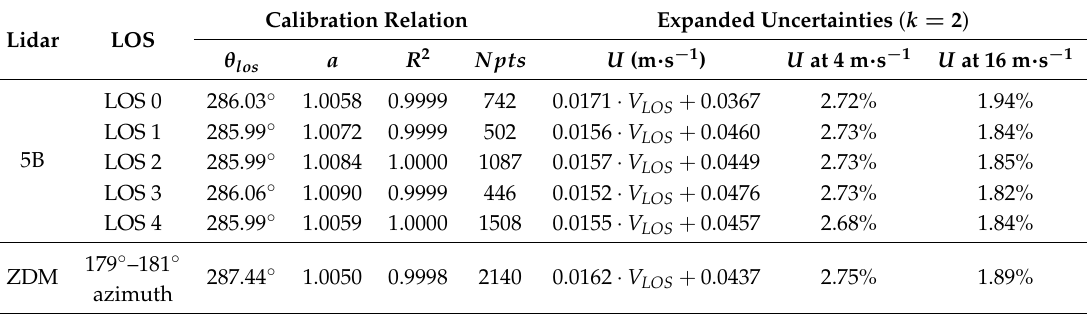
Table 1. Summary of LOS velocity calibration